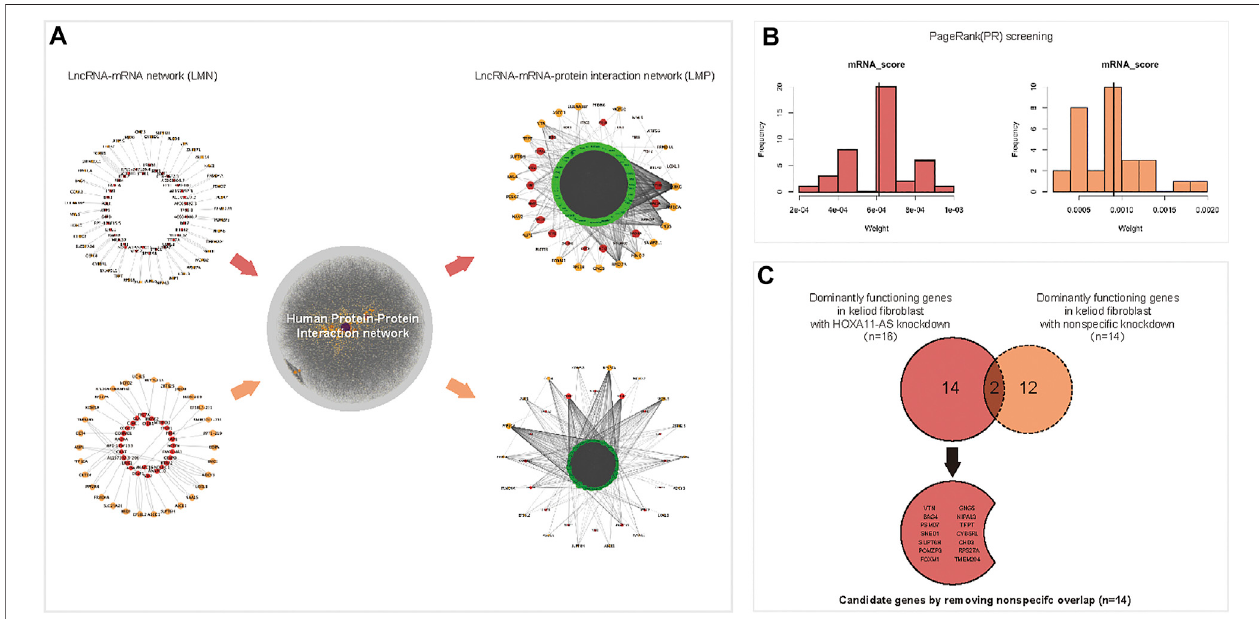
FIGURE 3 | Predicting dominant functional mRNAs in the HOXA11-AS regulatory network of keloid fi broblasts using interaction network construction and PageRank (PR) scoring. A lncRNA – mRNA interacted network was constructed using differentially expressed (DE) lncRNAs and DE mRNAs in keloid fi broblasts with HOXA11-AS knockdown based on cite- and sequence-matched prediction. A total of 39 lncRNAs (red nodes) corresponding to 63 mRNAs (orange nodes) were predicted by knocking downHOXA11-AS in keloid fi broblasts ( (A) , upper, left). Using the same protocol, a lncRNA – mRNA network was constructed with 28 lncRNAs (red nodes) corresponding to 30 mRNAs (orange nodes) in keloid fi broblasts with nonspeci fi c knockdown ( (A) , lower, left). An integrated lncRNA – mRNA – protein network using fi rst-neighbor genes (green band) linked to 39 lncRNAs (red nodes) and 63 mRNAs (orange nodes) were identi fi ed using DE mRNA pro fi les in keloid fi broblasts with HOXA11-AS-knockdown with the aid of the human protein – protein – interaction annotated network ( (A) , upper, right). Using the sameprotocol,theintegratedlncRNA – mRNA – proteinnetworkwasconstructedinkeloid fi broblastswithnonspeci fi cknockdown( (A) ,lower,right).Atotalof23mRNAs werepredictedtobedominantlyfunctioningmRNAsscreenedbythePRalgorithminkeloid fi broblastswithHOXA11-ASknockdown( (B) ,left).Usingthesameprotocol, 14 mRNAs were predicted in keloid fi broblasts with nonspeci fi c knockdown ( (B) , right). Among the 23 mRNAs, 16 mRNAs that were enriched in biological pathways in keloid fi broblasts were predicted to be involved in the HOXA11-AS pathway, two were also predicted to be involved in nonspeci fi c knockdown and were removed as “ noise. ” Consequently, 14 candidate mRNAs were determined to be regulated by HOXA11-AS in keloid fi broblasts (C) .